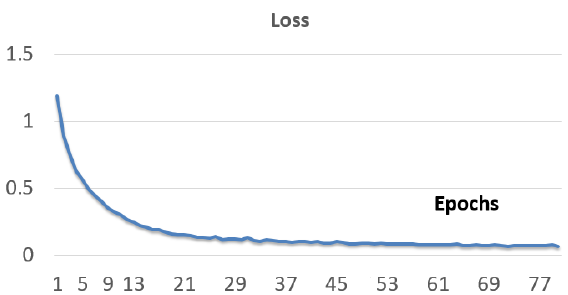
Figure 9. Curve of the loss during the training of BiseNet on Potsdam